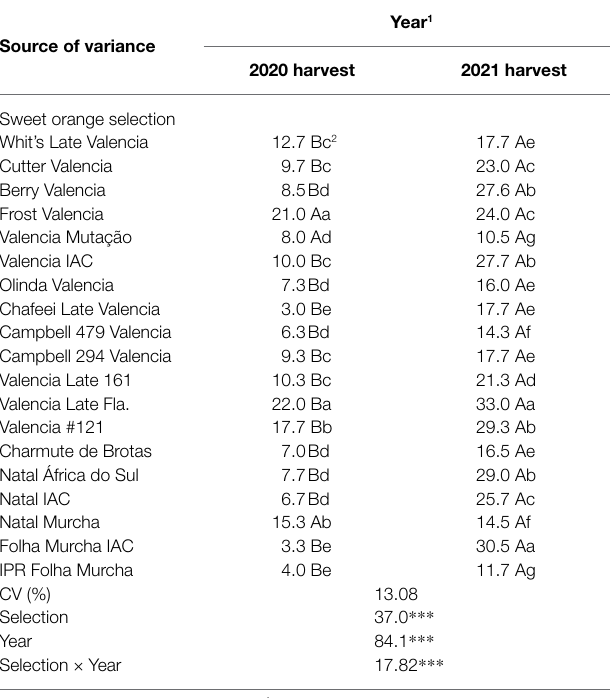
TABLE 8 | Incidence of harvested fruit with citrus canker in 19 late-season sweet orange selections grafted onto Rangpur lime rootstock harvested in 2020 and 2021 in Guairaçá, state of Paraná,